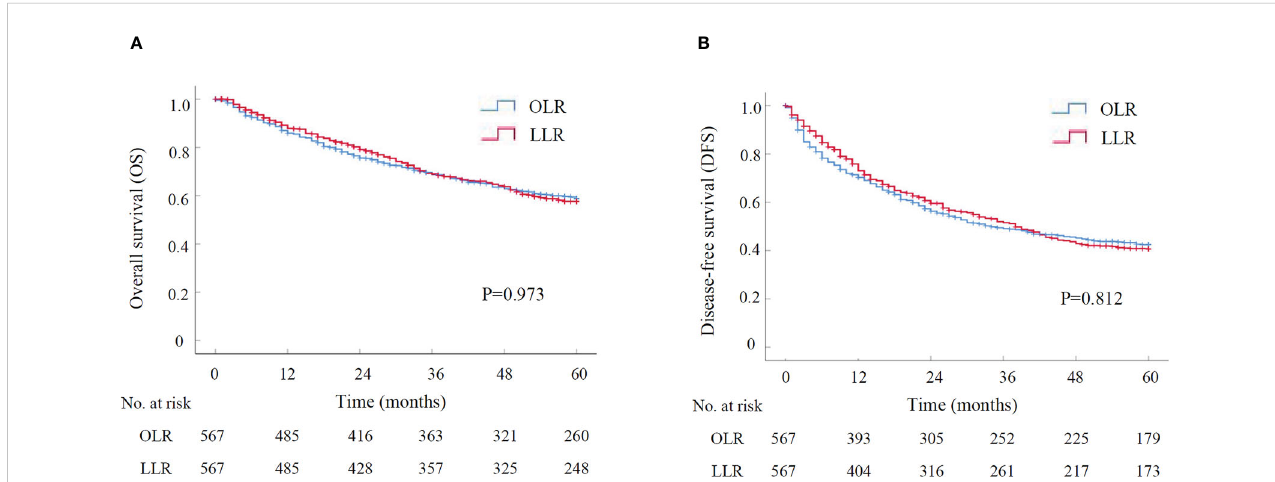
FIGURE 1 The survival curve of LLR versus OLR for HCCs after PSM by Kaplan-Meier analysis (N=567 for each group). (A) Overall survival; (B) Disease-free survival. LLR, laparoscopic liver resection; OLR, open liver resection; PSM, propensity score